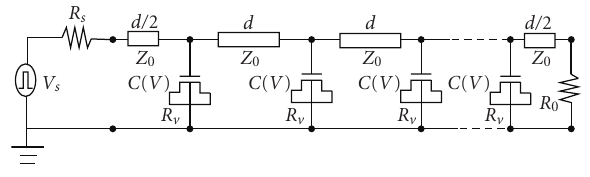
Figure 3: Circuit diagram of the NLTL configuration.